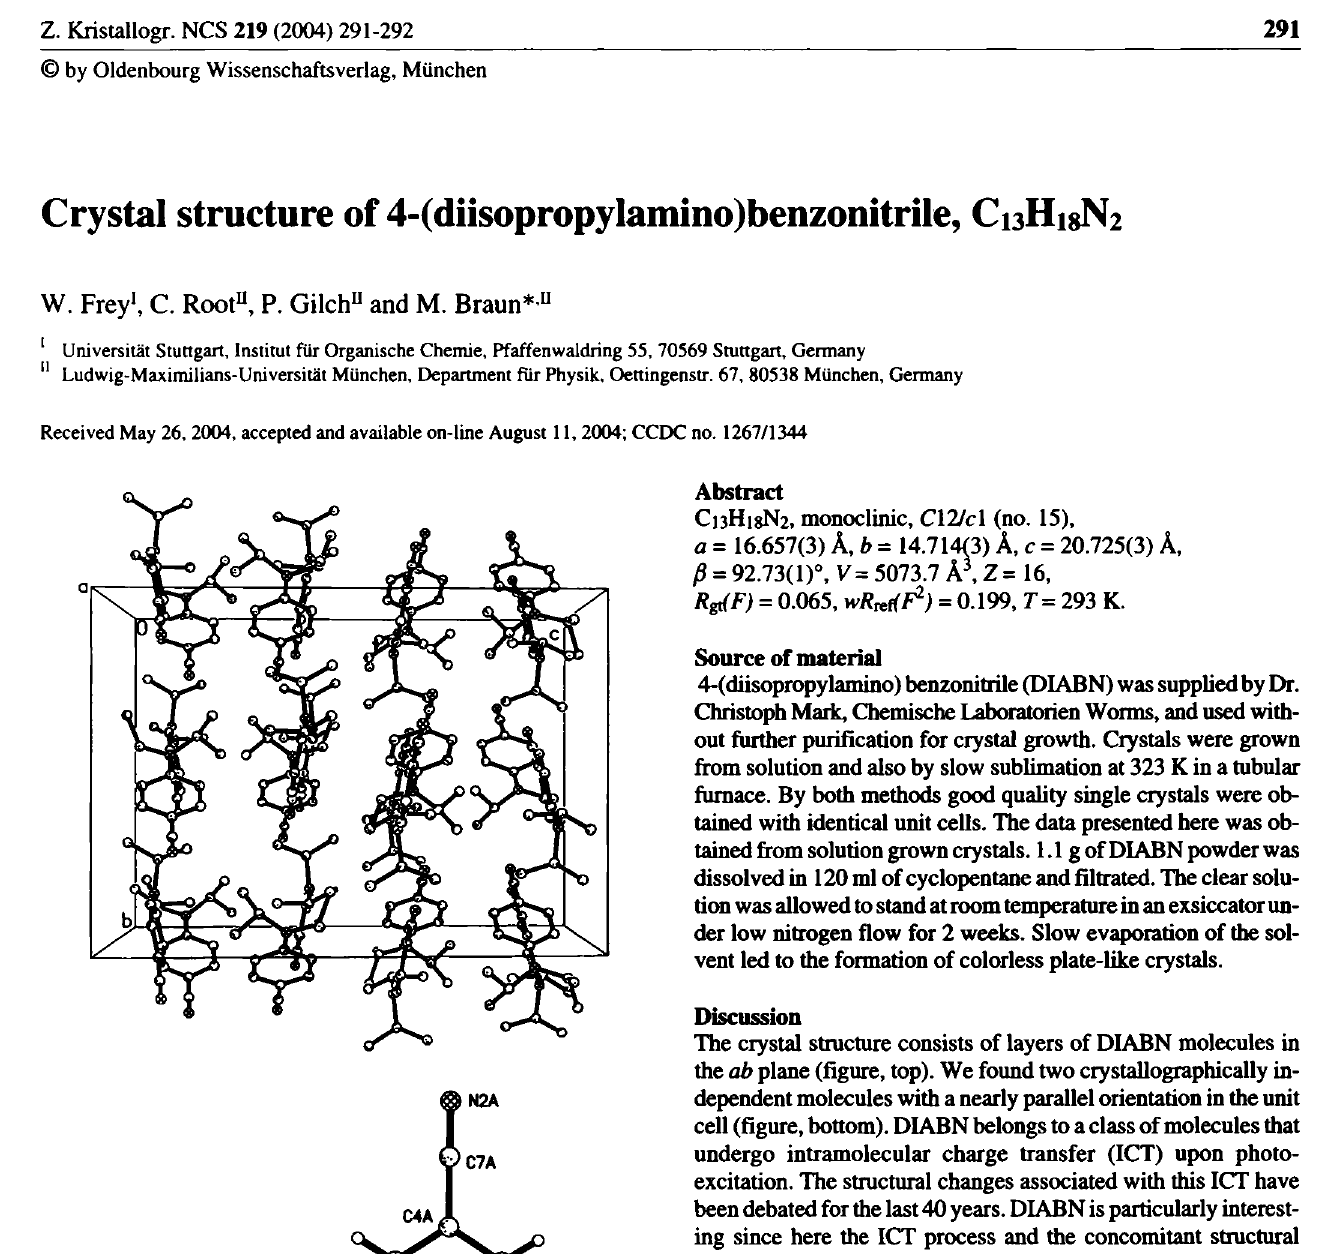
Table 1. Data collection and